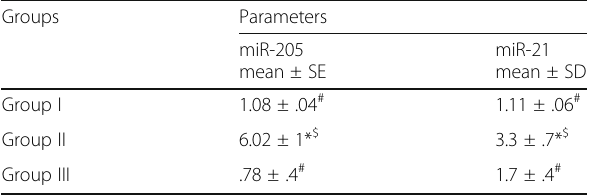
Table 2 Expression values of the miRNA-205 and miRNA-21